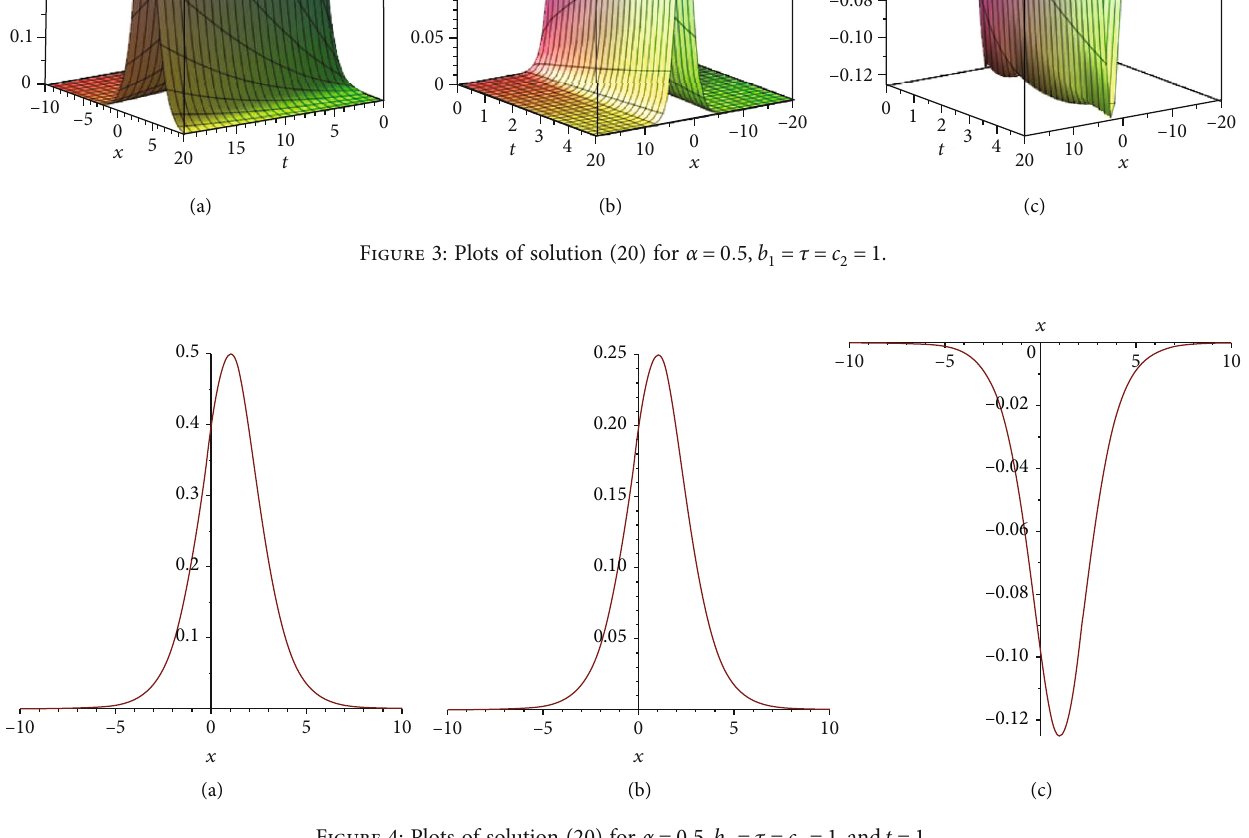
= τ = c = 1, and t = 1 . 1 2